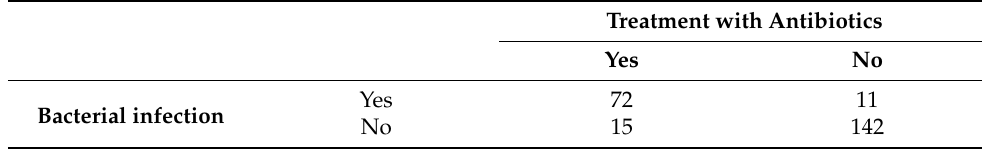
Table 3. Concordance between the classification by the adjudication committee and antibiotherapy (TEST set; n =